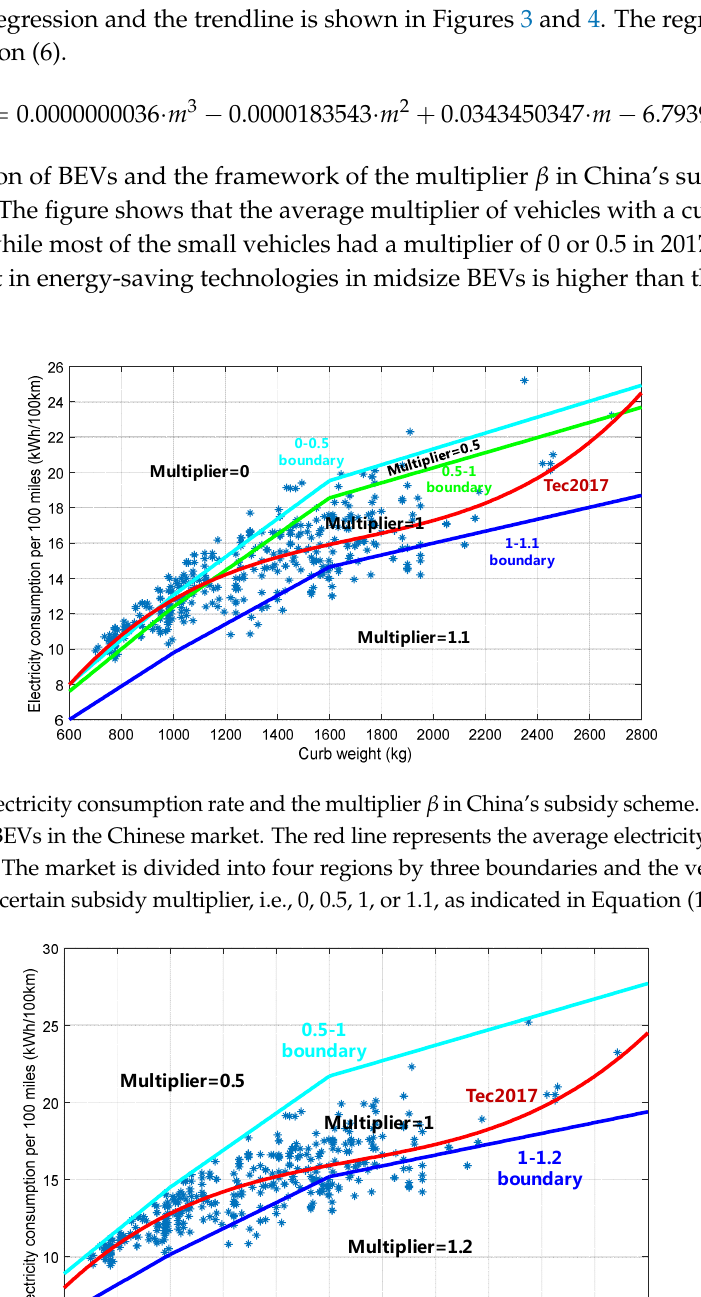
Figure 2. The accounting framework of the bottom-up model.